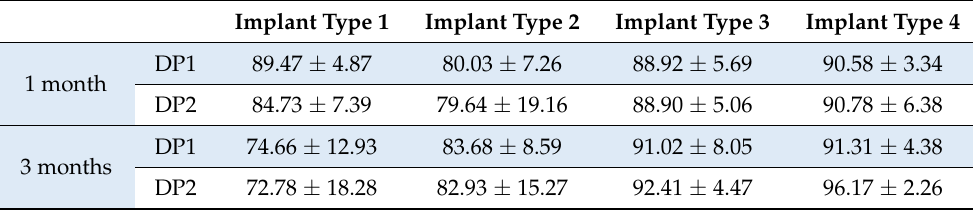
Figure 6. Coronal aspect bone-to-implant contact (BIC) after one month (1 m) and 3 months (3 m) for the four implant types. Data are presented as the average ± sd. * denotes p < 0.05. Table 1. Total bone-to-implant contact (BIC) values of implants types 1–4 inserted with the standard drilling protocol (DP2) and the extra underdrilling protocol (DP1). Values after 1 month and 3 months of healing are presented as the average (%) ± sd.